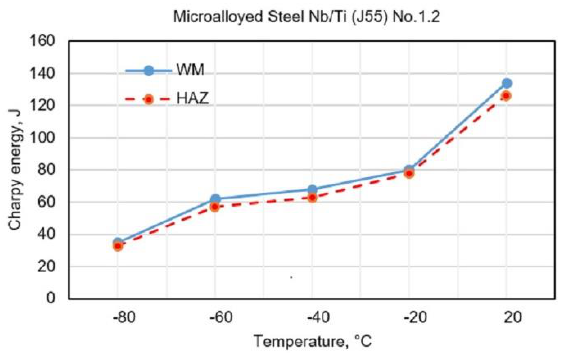
Figure 3. Test results of impact energy at test temperatures of welded joints made with electrode No.1.1.